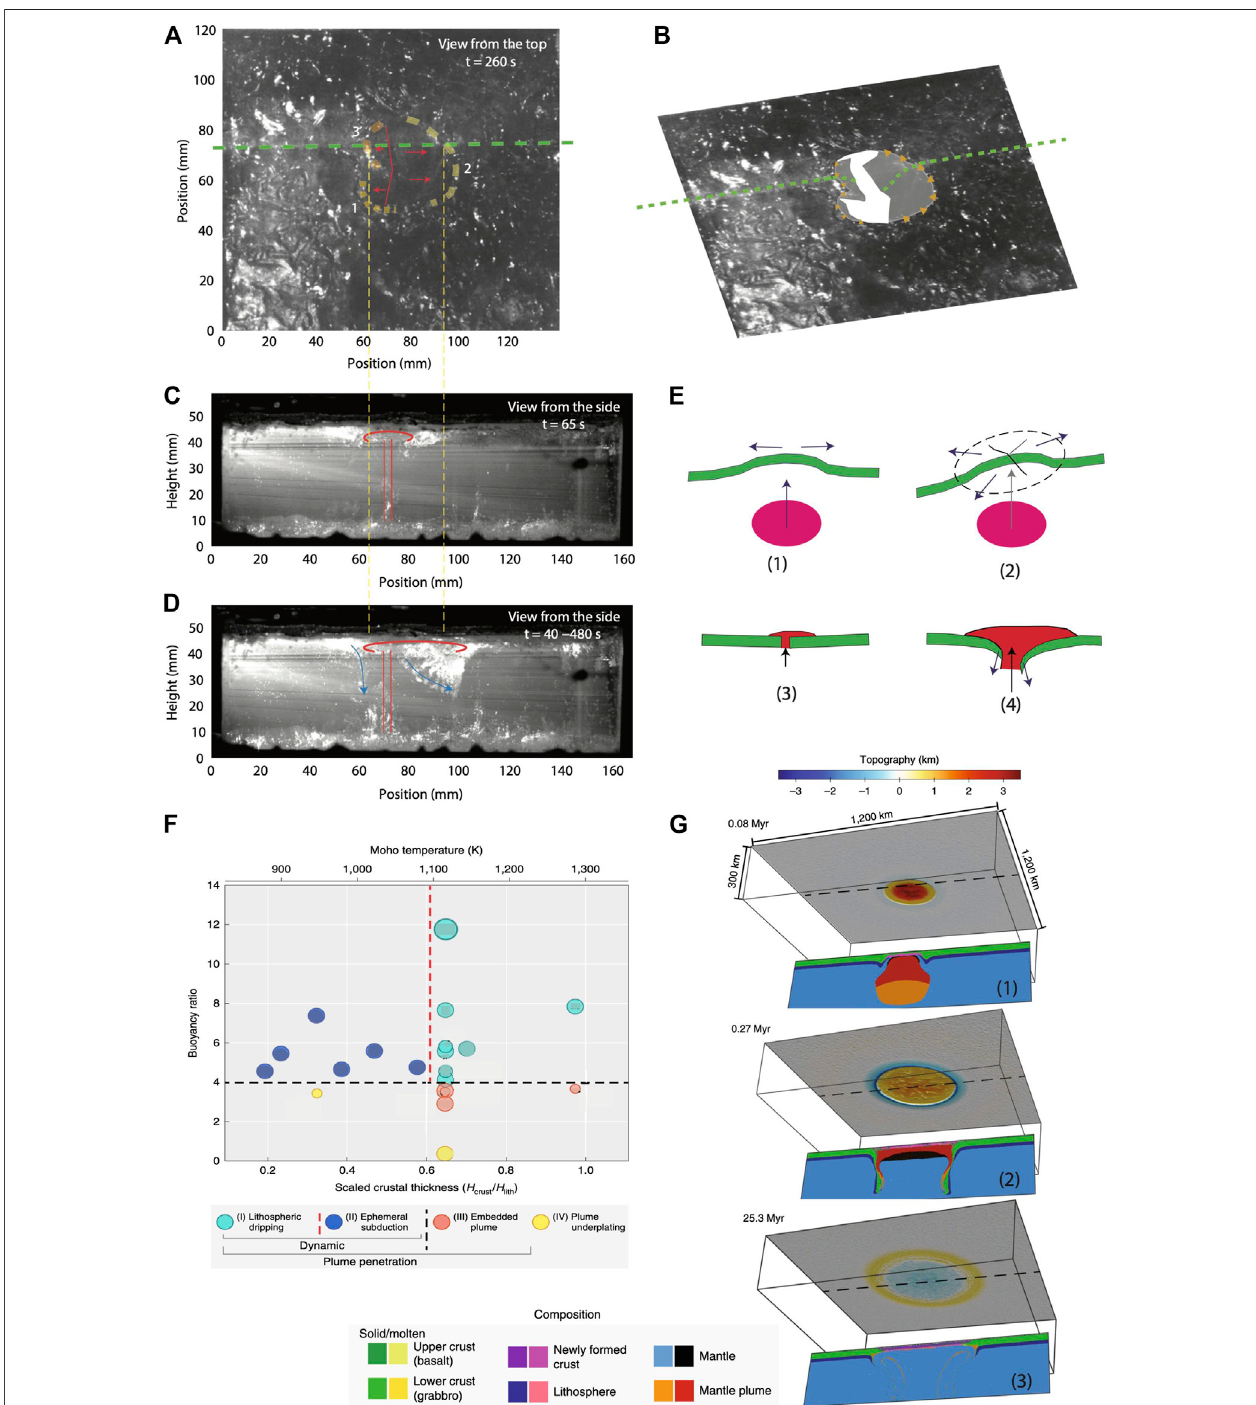
FIGURE 11 | (A – E) Analogue modeling of plume-induced subduction initiation (adapted from Davaille et al., 2017). (A,B) Top views and (C,D) side views (the locationofcross-sectionisshownbyagreendashedlinein (A,B) )ofexperimentalresultsatdifferenttimes.Theredlinesillustratetheplume.Thenumbersin (A) standfor locationofthreebulgeswhichforminthemodel duetodevelopmentofthree slabs.Slabsareshown bywhitecolorin (A,C,D) .Theshapeofthreeslabswhichformdue to plume-lithosphere interaction are shown in (C) — light grey areas. (D) The composite of 12 superimposed images taken every 40 s. (E) Schematics showing the developmentofplume-inducedsubduction. (F,G) Modeling results ofGülcher etal.(2020). (F) Dependence ofdifferentregimesonthebuoyancy ratio(non-dimensional ratio of the plume buoyancy and lithospheric strength) and the scaled crustal thickness (non-dimensional ratio of crustal thickness ( H crust ) over lithospheric thickness ( H lith )). The scaled crustal thickness is analogous to the Moho temperature (top axis). Circles refer to the numerical experiments, and their relative sizes represent their